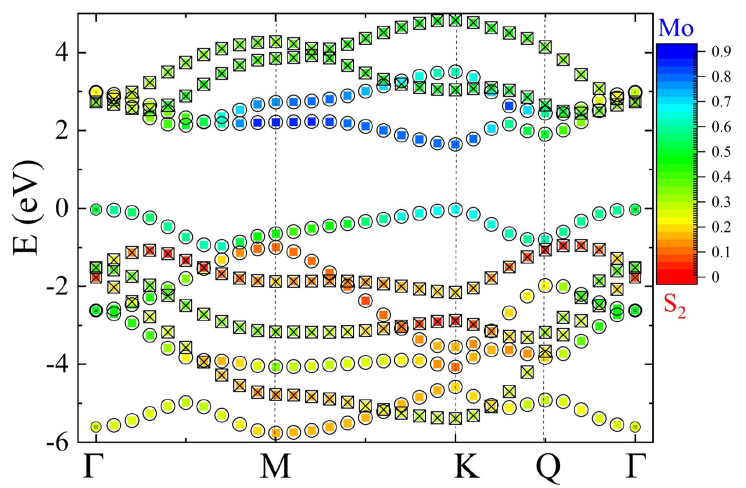
Figure 3. Color-mapped localization of a given k-resolved eigenenergy on Mo and S 2 spheres and symmetry of eigenvalues across the Brillouin zone. Circles (crossed rectangles) denote symmetric (anti-symmetric) orbitals with respect to the metal